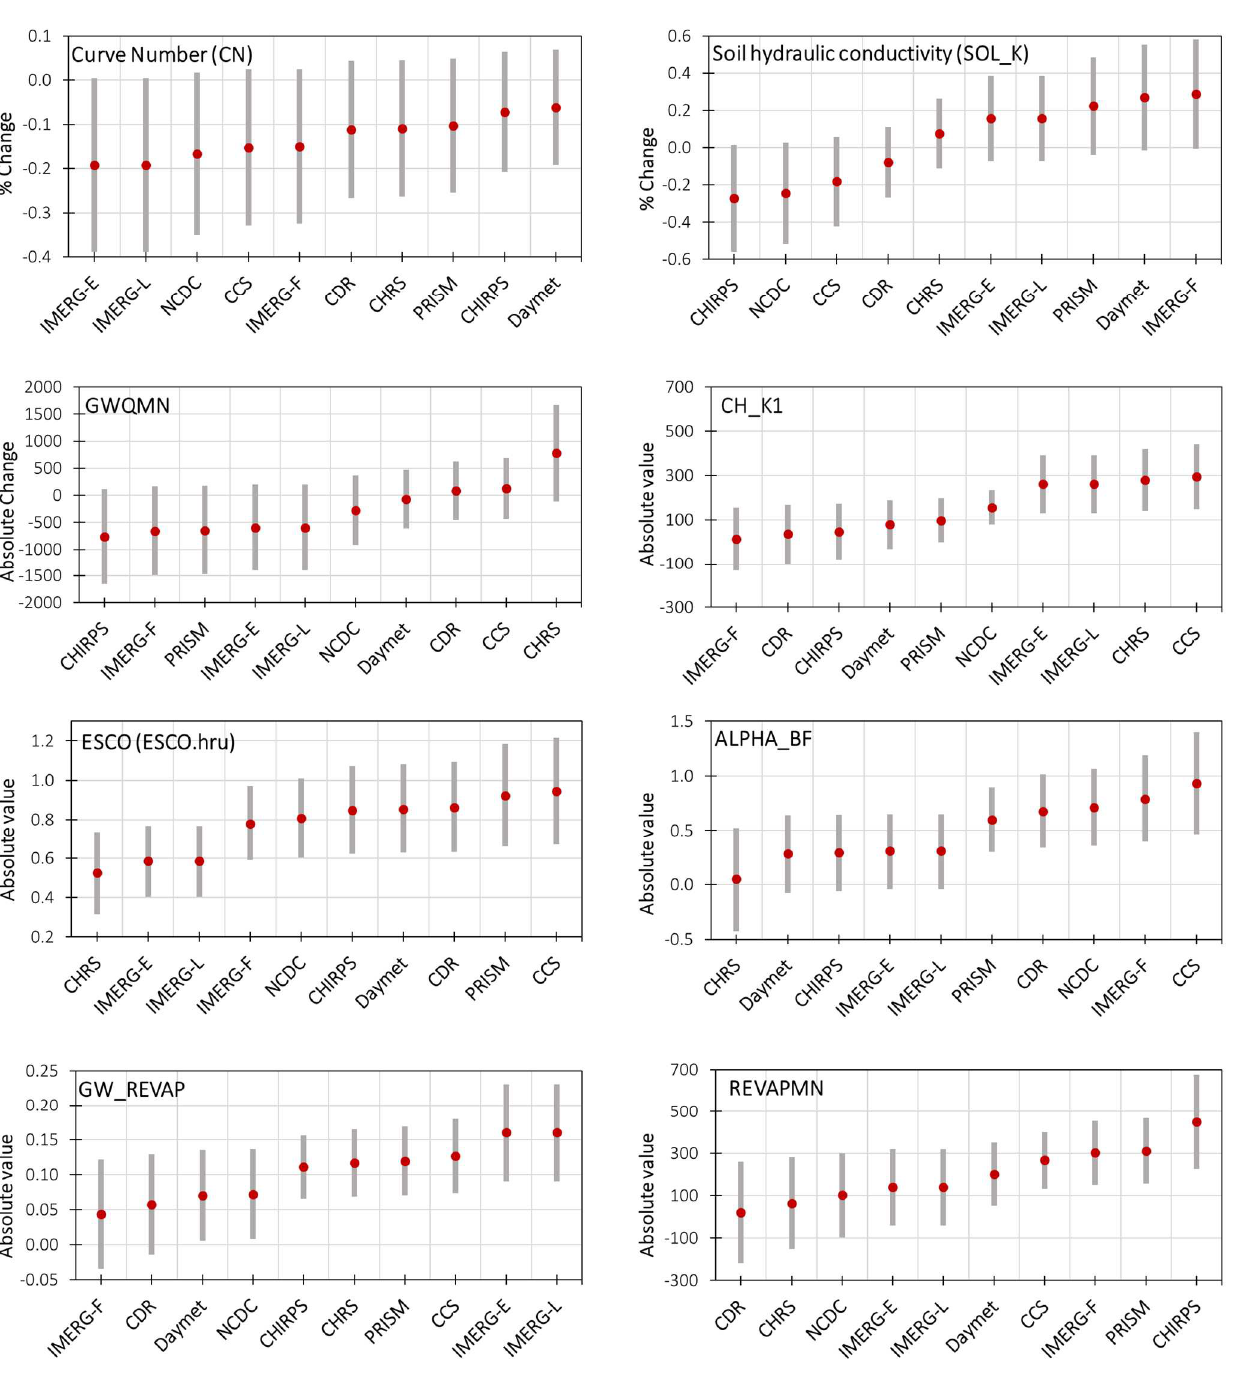
Figure 8. SWAT − CUP suggested input parameters range (gray bars) and best parameter estimates (red circle) provided after running 2000 model simulations with given initial ranges of parameters.